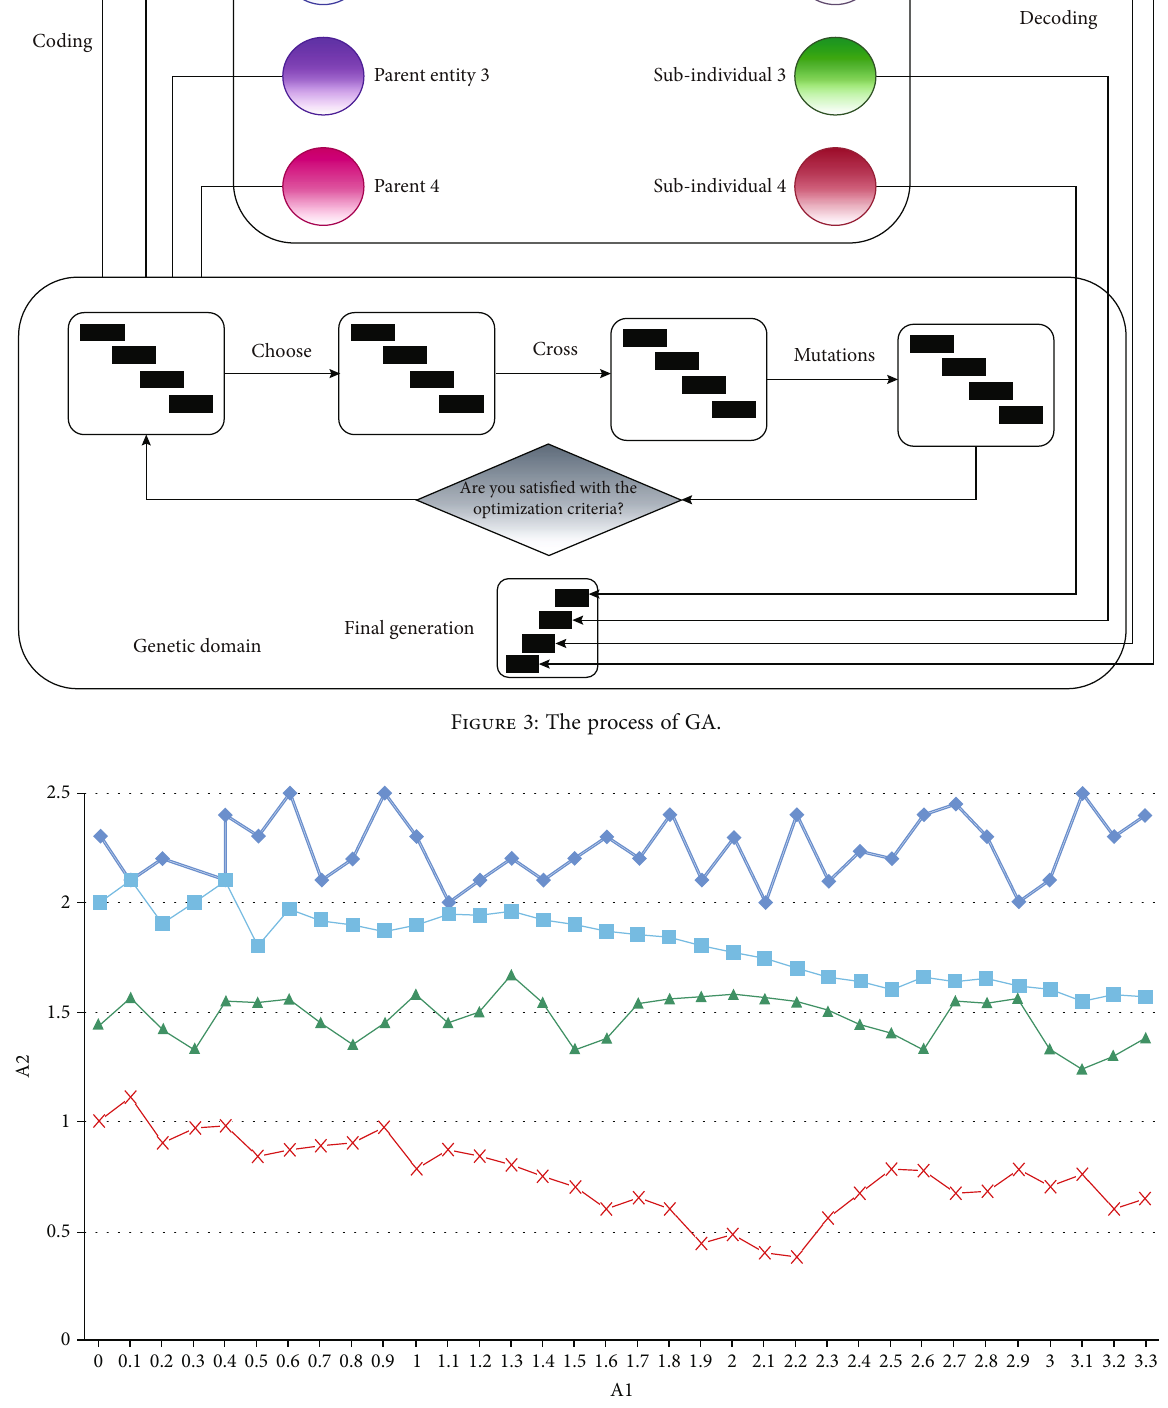
Figure 4: Test function